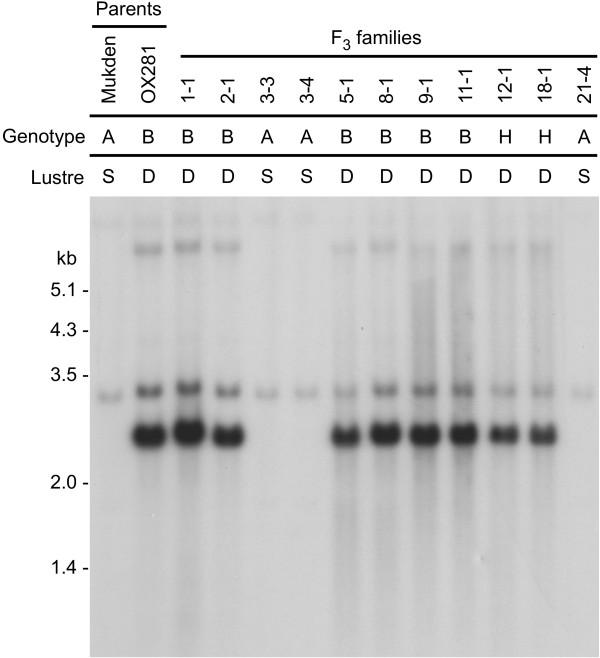
Segregation of Hps polymorphisms and seed lustre in a soybean cross. An analysis of a genetic cross between two different soybean lines polymorphic for Hps and seed lustre phenotype. Soybean (Glycine max) genomic DNA (30 μg each lane) was digested with Bgl II and separated by agarose gel electrophoresis. The DNA was transferred to Nylon blotting membrane and probed with 32P labelled Hps cDNA (GenBank accession number AF100159). Shown above each lane is: Lustre, the seed lustre for each parent or F3 family (F4 seed); Genotype, the genotype for molecular marker A963_CAPS [2] where A is homozygous for the Mukden allele, B is homozygous for the OX281 allele, and H is heterozygous. The parental names and F3 family numbers are also shown.